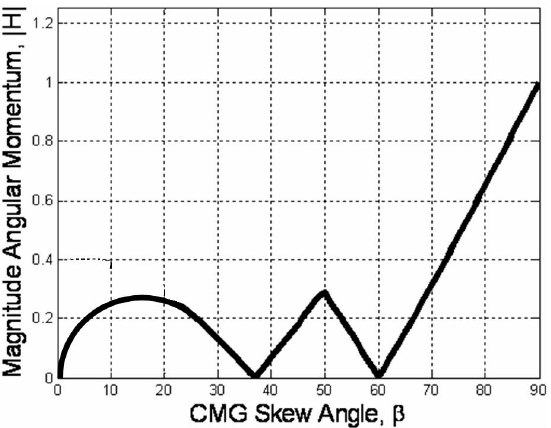
Figure 1 . ITERATION: Optimum singularity-free CMG skew angle, β .